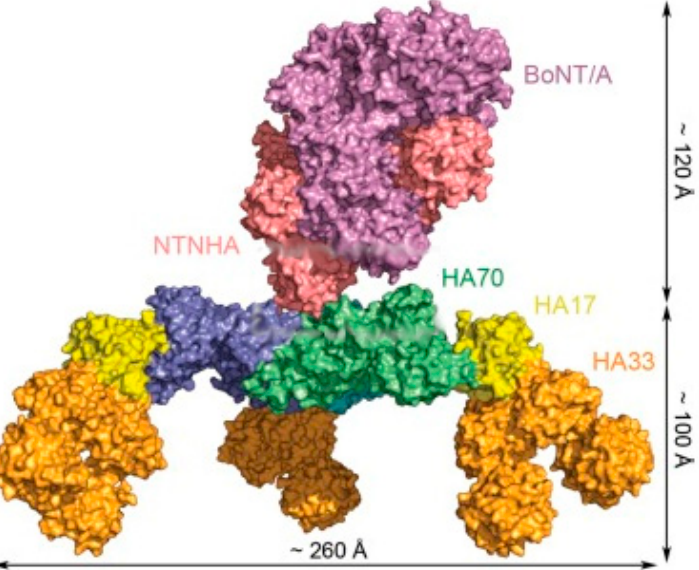
Figure 15. Molecular structure of BoNT-A complex reconstructed by fitting the three-dimensional structures of the BoNT-A and neurotoxin-binding protein (NTNHA) and HA70-HA-17-HA33 complex modules into the electron microscopy image. (Adapted with permission from Ref. [25]. Copyright 2013 Lee et al.).